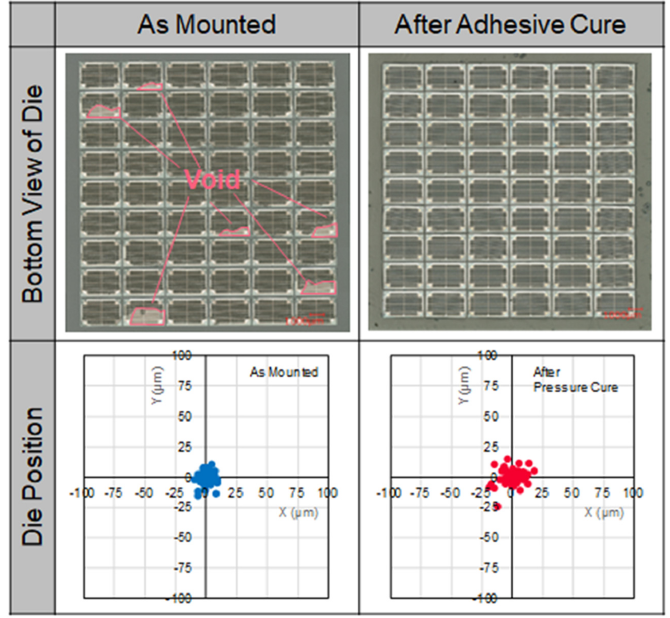
Figure 19. Observation of void in adhesive between the base wafer and Si capacitor (pictures in top-left and right ); and die placement accuracy before and after the adhesive curing step ( bottom-left and right ).